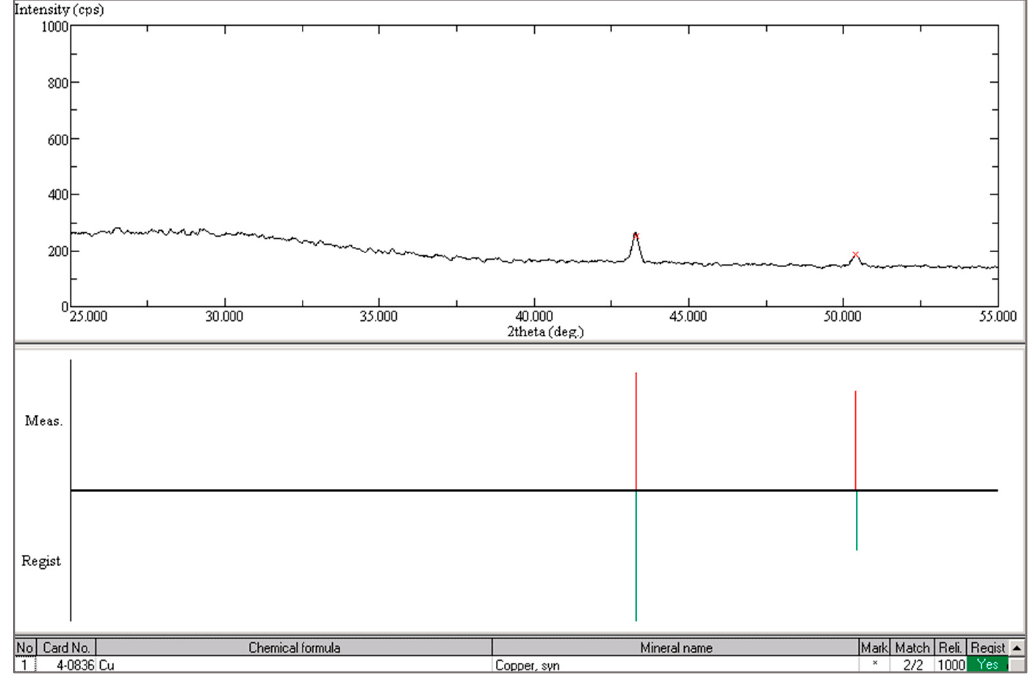
Figure 43. X-ray diffraction pattern of “dullish” red glass, demonstrating the presence of metallic copper (KH_R1 red natron-based Egypt I glass tessera from Khirbet al-Mafjar, Palestine [23]).